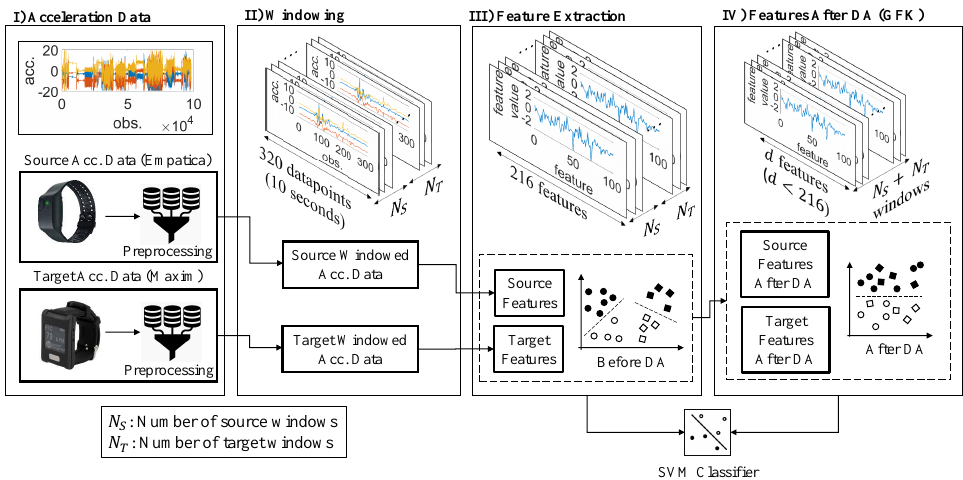
Figure 4. An illustration of the methodology for the cross-sensor